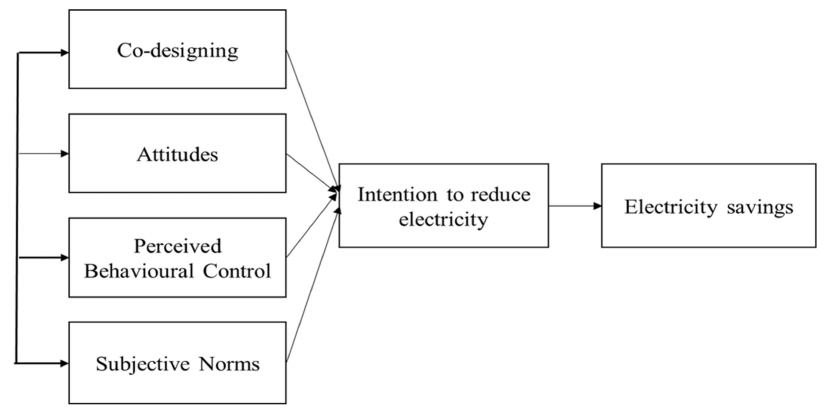
Figure 1. Determinants of electricity-use